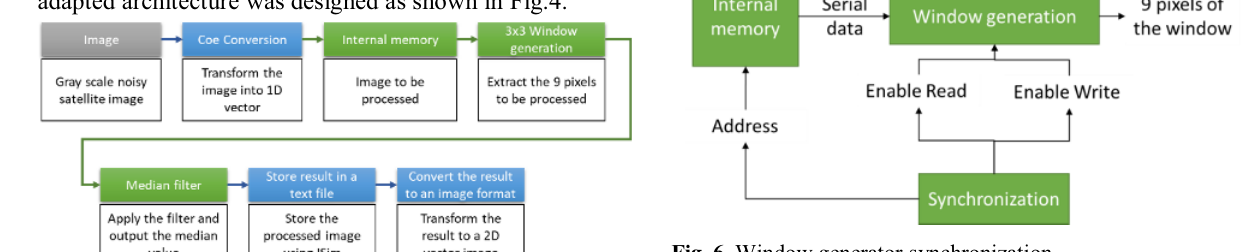
Fig. 6. Window generator synchronization